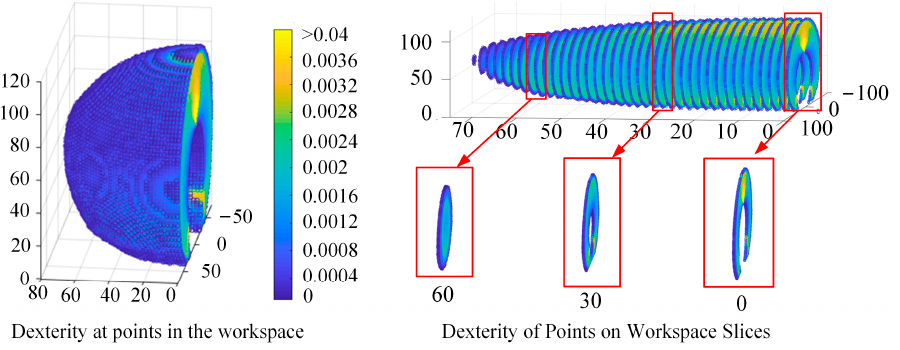
Figure 11. The dexterity distribution chart under the current configuration.